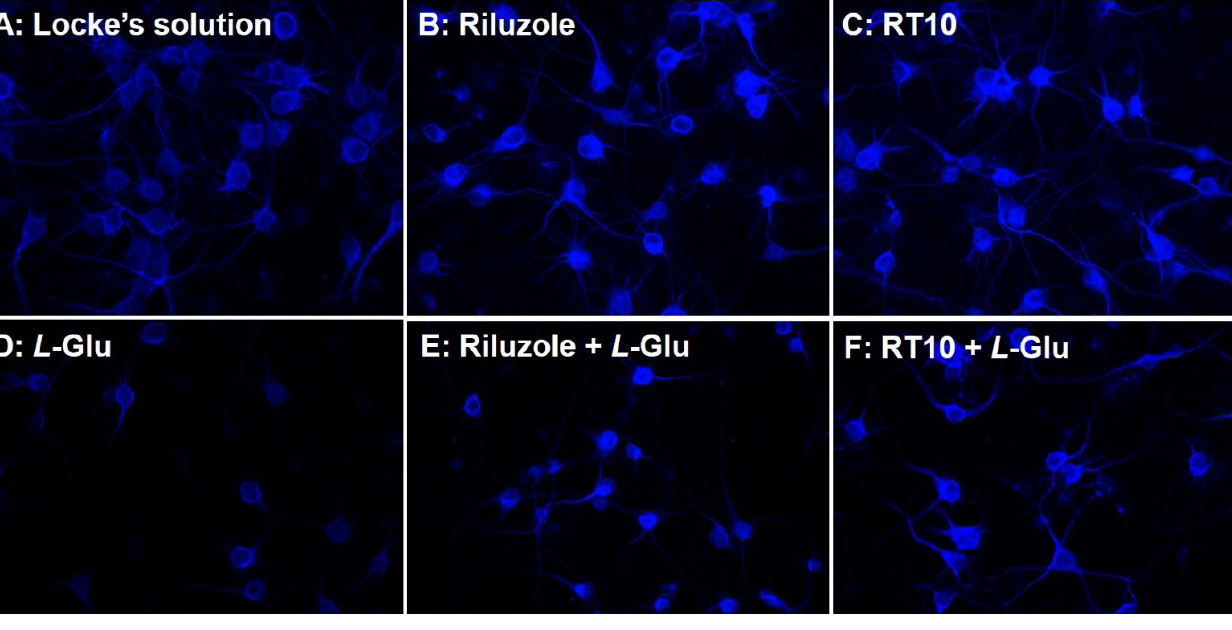
Figure 4. Immunological labeling with anti-MAP2 in primary cortical neuron/glia cultures. Treatments were performed three hours prior to incubation of L -Glu, which lasted for 12 hours. A: Locke’s solution; B: Riluzole (100 μM); C: RT10 (2μg / ml); D) L -Glu (5 mM); E) Riluzole (100 μM) + L -Glu (5 mM); F) RT10 (2μg / ml) + L-Glu (5mM). 200x magnification.